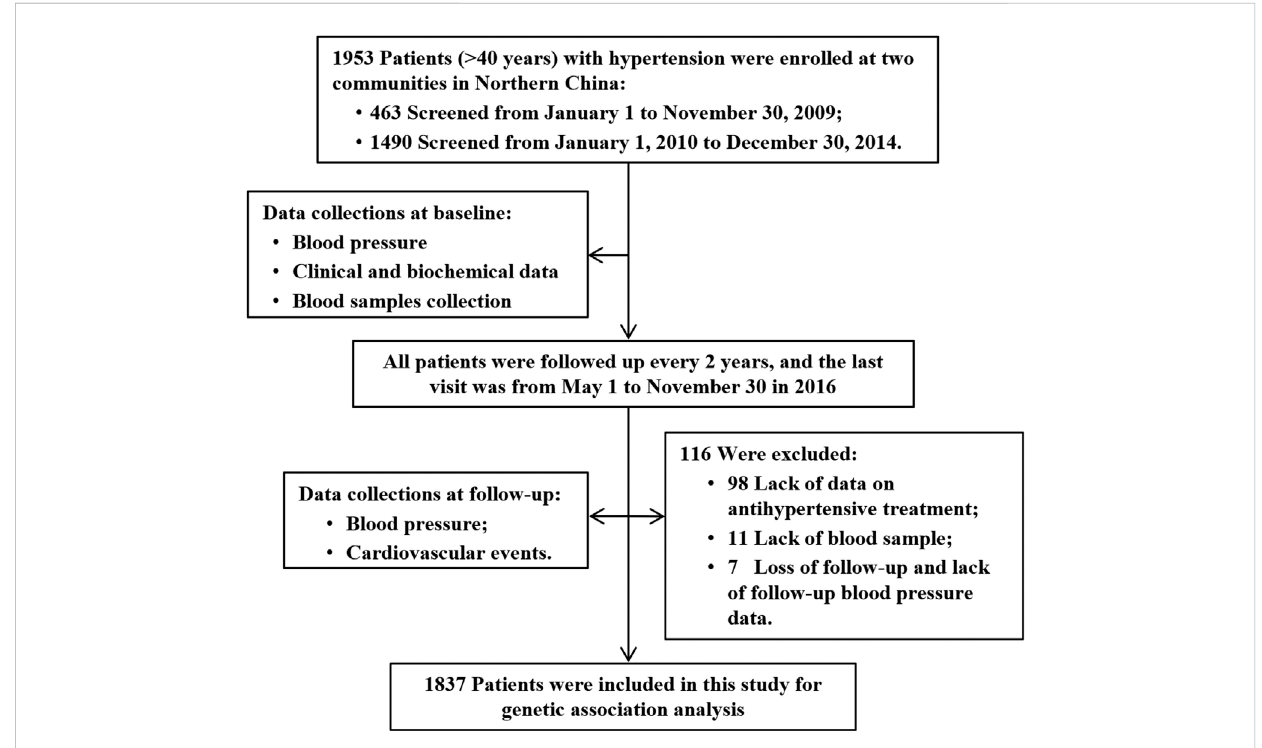
FIGURE 1 Flowchart of the current study. Cardiovascular events including stroke, myocardial infarction, coronary revascularization, hospitalization for unstable angina or acute decompensated heart failure, and deaths from cardiovascular